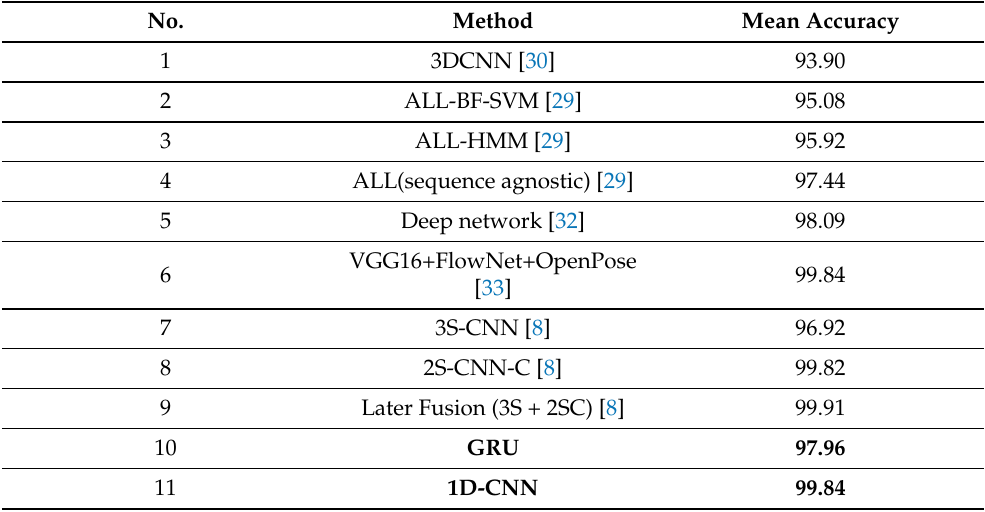
Table 8. Comparison with state-of-the-art SLR methods on the LSA64 Dataset. No.